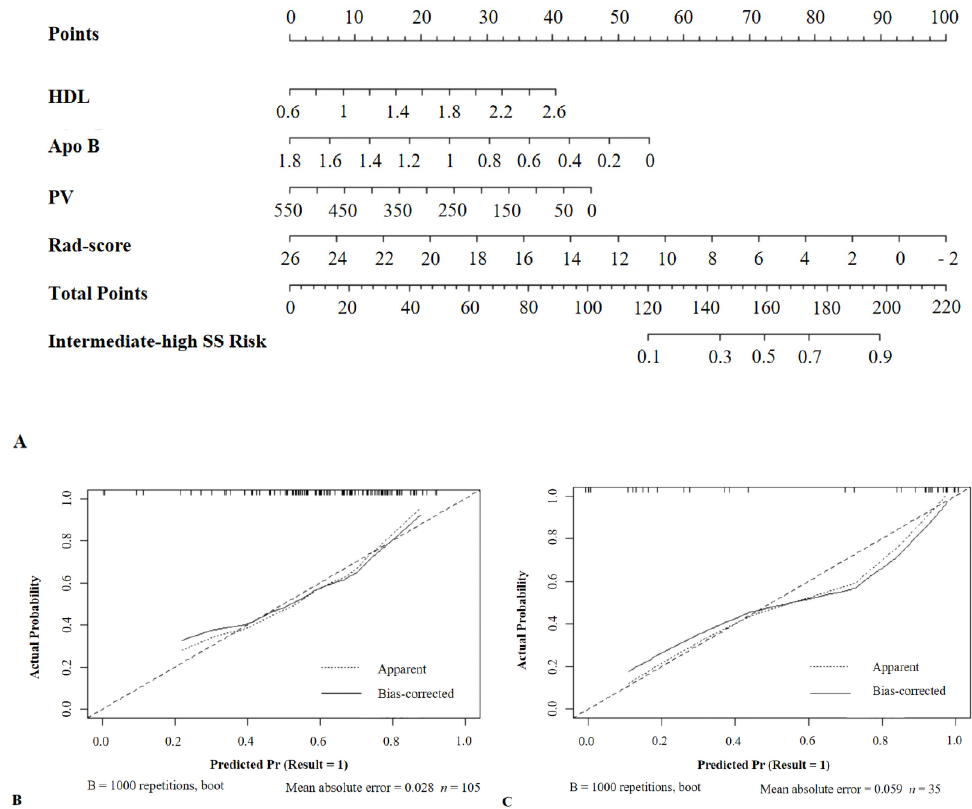
Figure 6. Nomogram combining HDL, Apo B, plaque volume, and Rad-score. ( A ) Nomogram plot. ( B ) Calibration graph for the training set. ( C ) Calibration graph for the validation set. HDL, high-density lipoprotein; ApoB, apolipoprotein B; PV, plaque volume; SS, SYNTAX scores. Result = 1: The SS was intermediate-high.